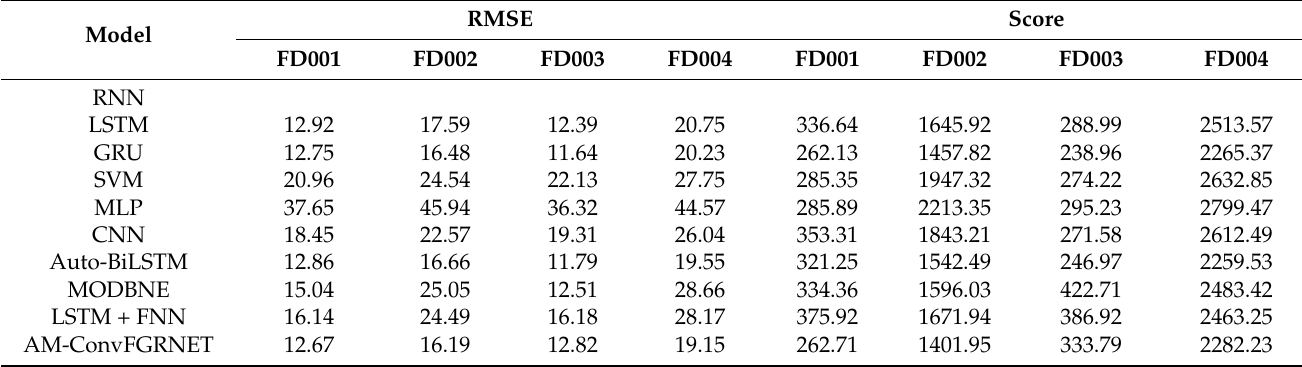
Table 12. Model performance comparison for RUL prediction.